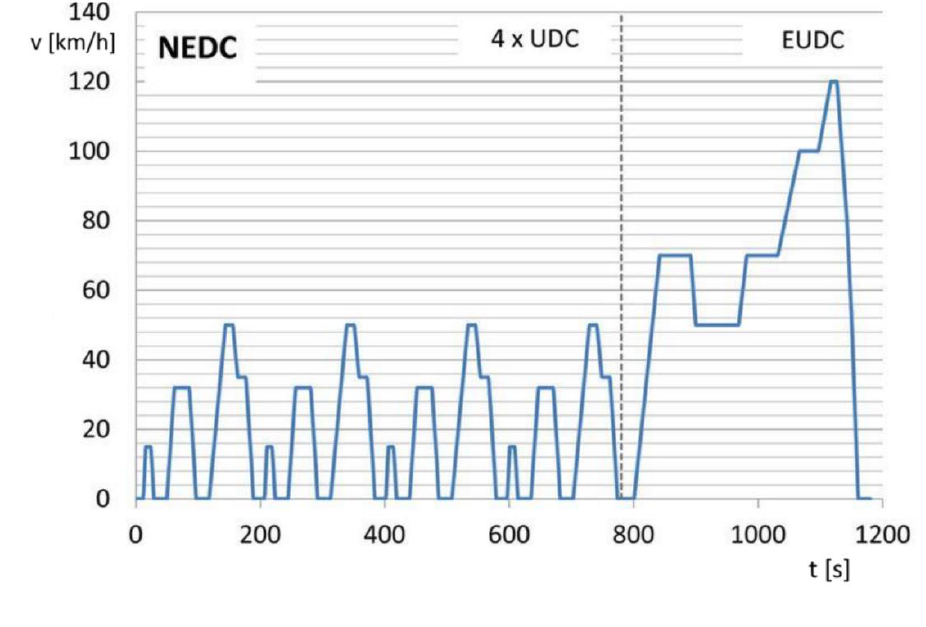
Figure 14. NEDC Figure 14. NEDC cycle.